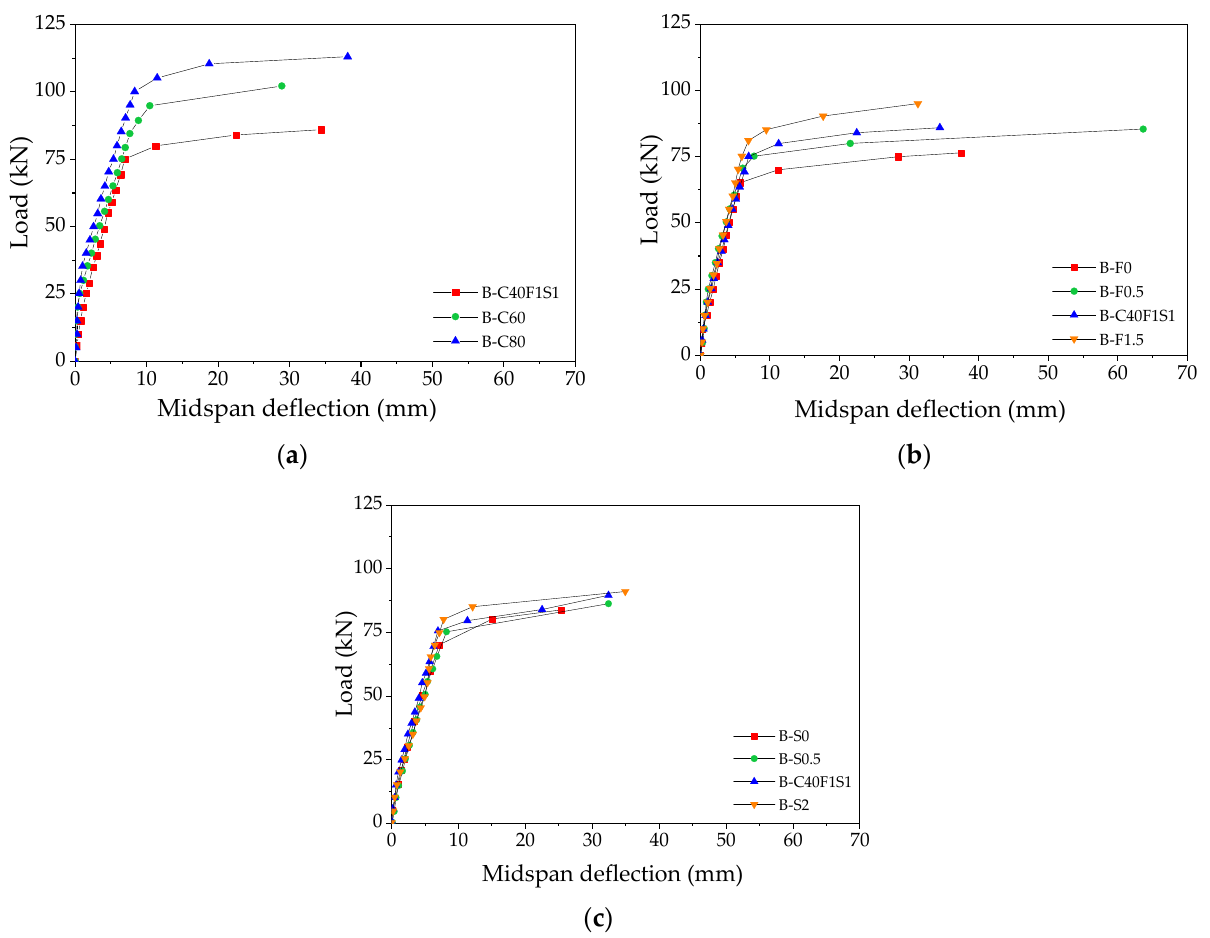
Figure 4. Load–deflection relationship of specimens with different ( a ) concrete strength; ( b ) volume fraction of steel fiber; ( c ) amount of NS.